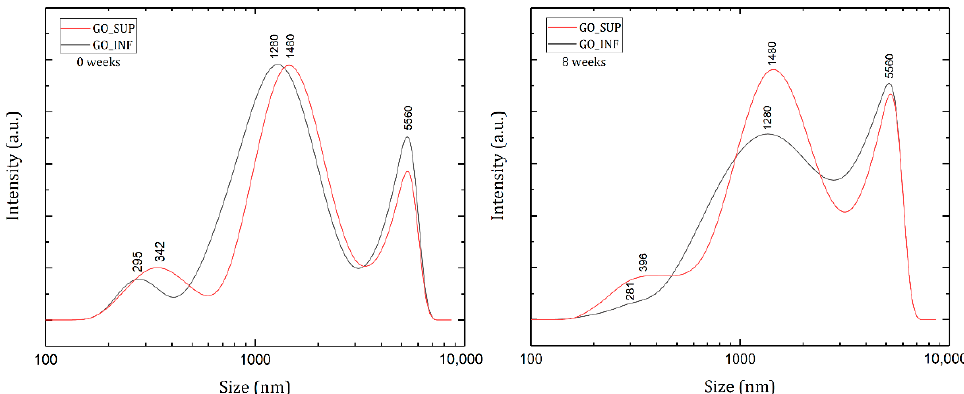
Figure 3. Size distributions by intensity obtained for GO suspension fractions GO_SUP and GO_INF immediately after the synthesis process was done ( left ) and 8 weeks later ( right ).